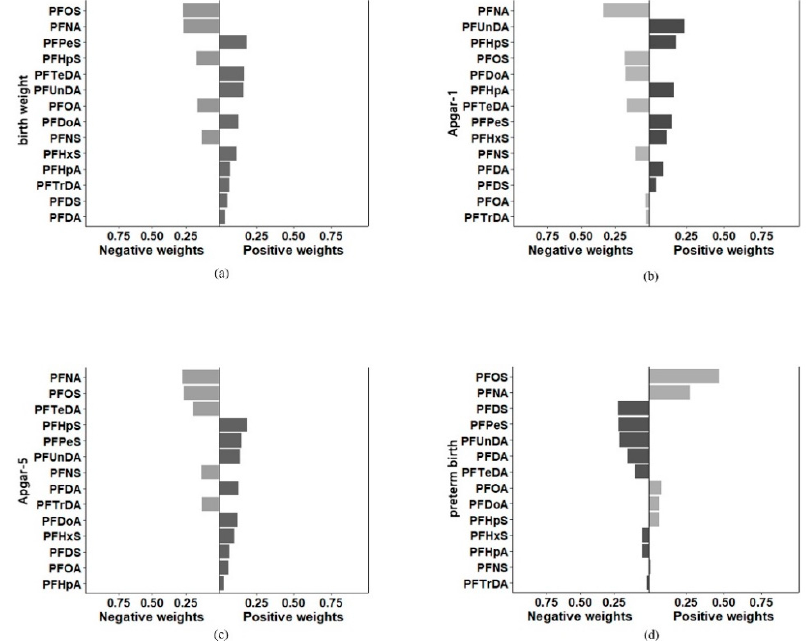
Figure 3. Quantile-based g-computation approach of PFAS on birth outcomes. ( a ) birth weight, ( b